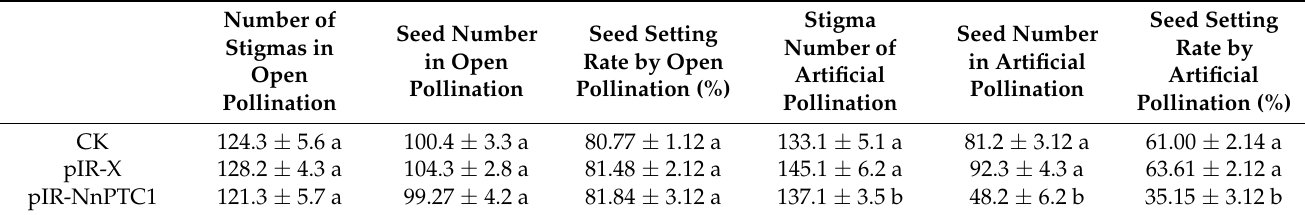
Table 1. Self-breeding of ‘Jinfurong 1’ after transient transformation.